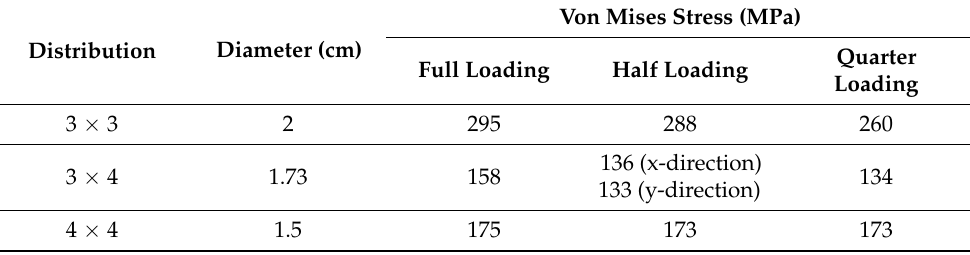
Table 4. Maximum von Mises stress in PEHs. (total cross section area = 28.37 cm 2 ).